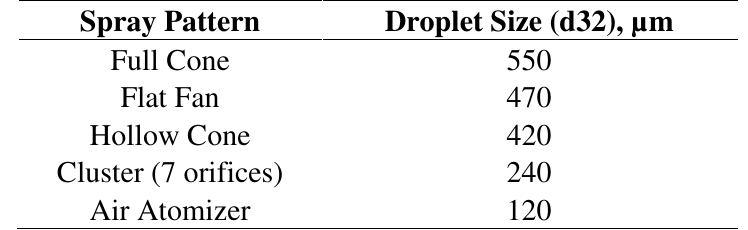
Table 2. Relative efficiency of various nozzle designs/spraying 20 L/min at 3 bar [15].